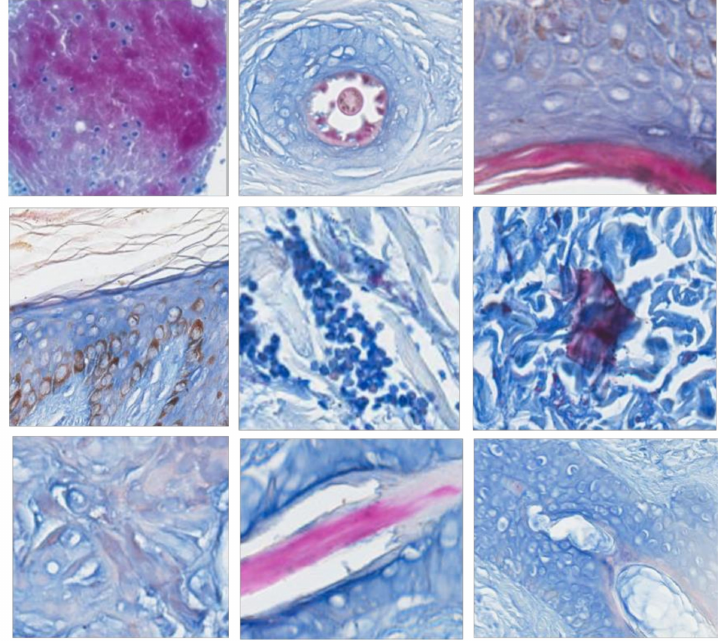
Figure 2. Reddish and violaceous tissues collected as negative samples in the splendid